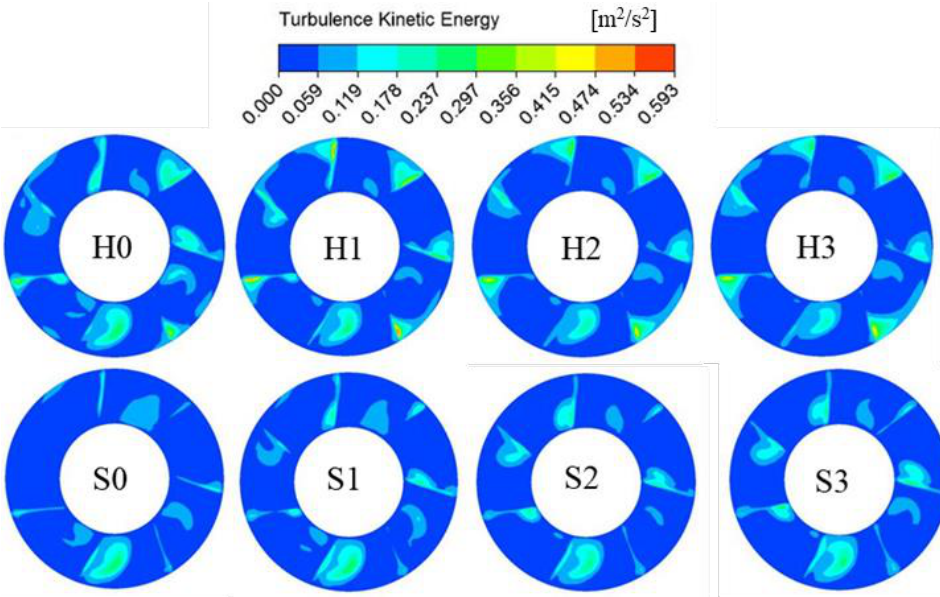
Figure 7. Turbulent kinetic energy distribution at the outlet of the guide vane.